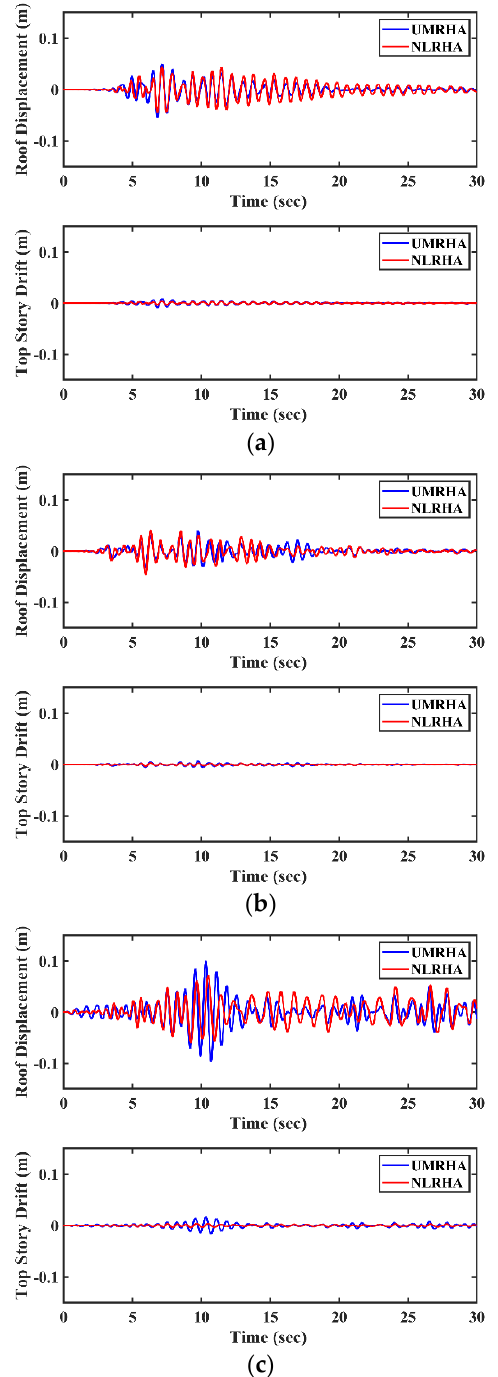
Figure 18. Comparison of roof displacement and top-story drift of RES open ground-story frame subjected to the selected ground motions: ( a ) Imperial Valley; ( b ) Kobe; ( c ) Landers.